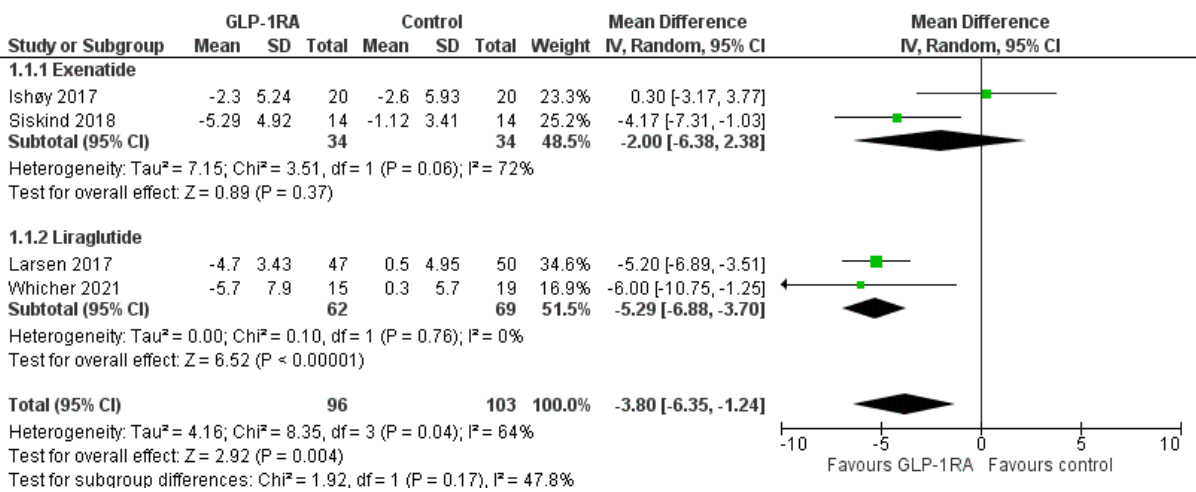
Figure 1. Flow diagram depicting the study selection process.